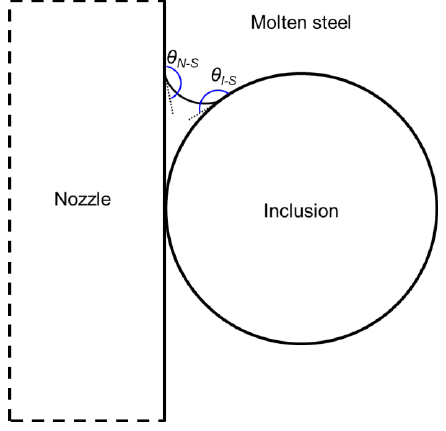
Figure 10. Schematic of attachment mechanism of an inclusion to the nozzle wall.